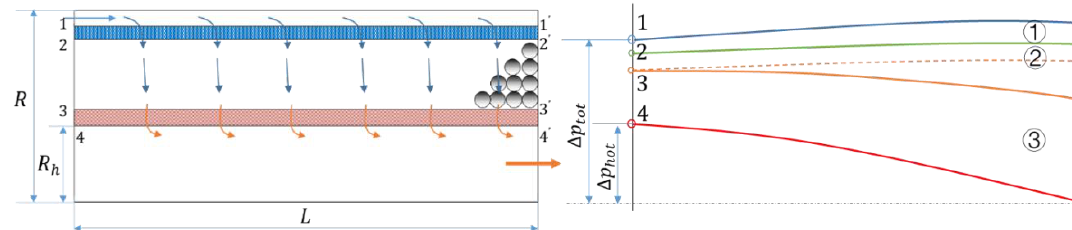
Figure 3. A simplified view of the PBR core and a schematic diagram of the pressure profile along the axial direction in PBR at several radial positions. 1-1’, outer cold frit interface; 2-2’, inner cold frit interface; 3-3’, outer hot frit interface; 4-4’, inner hot frit interface; R , radius of the bare core; R h , radius of the hot gas channel; ∆𝑝 𝑡𝑜𝑡 , total pressure drop; ∆𝑝 ℎ𝑜𝑡 , pressure drop within hot gas channel; L , length of the core.